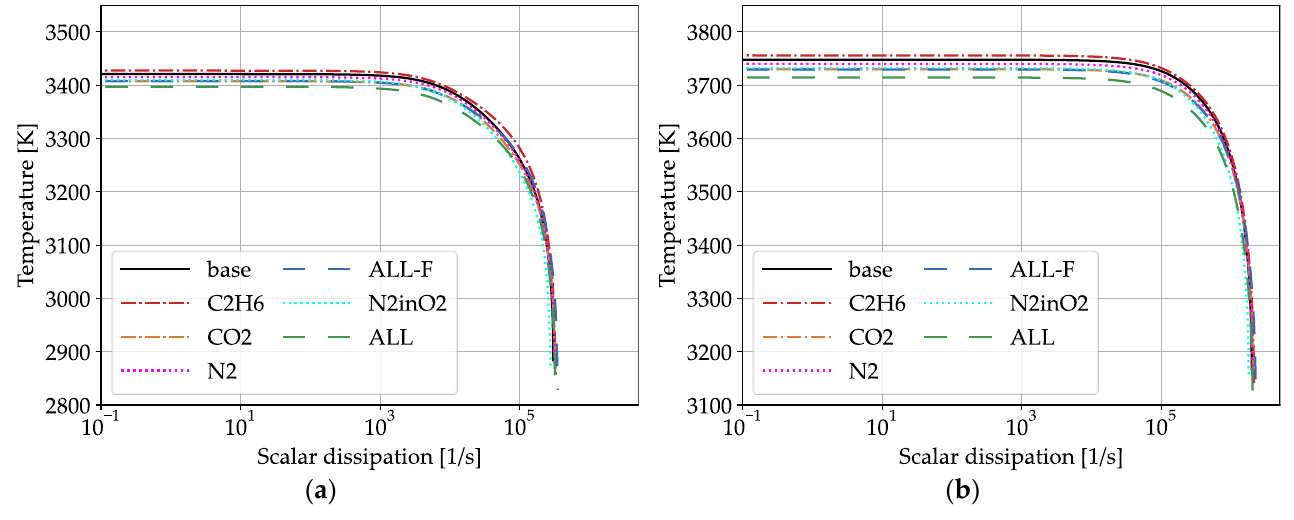
Figure 4. Temperature over scalar dissipation at the respective stoichiometric point (ROF = 4) for different pollutions of the fuel and/or oxidizer at: ( a ) 2 MPa and ( b ) 20 MPa. Table 6. Maximum flame temperature at stoichiometric mixture fraction for different impurities of the fuel and/or the oxidizer at different pressures (counter flow diffusion flame).